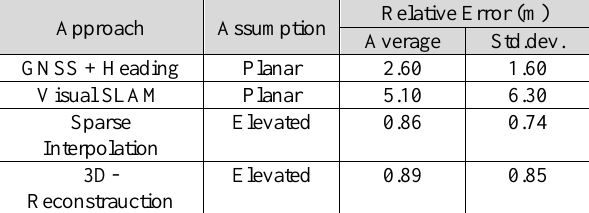
Table 1: Relative orthophoto integrity errors for all approaches